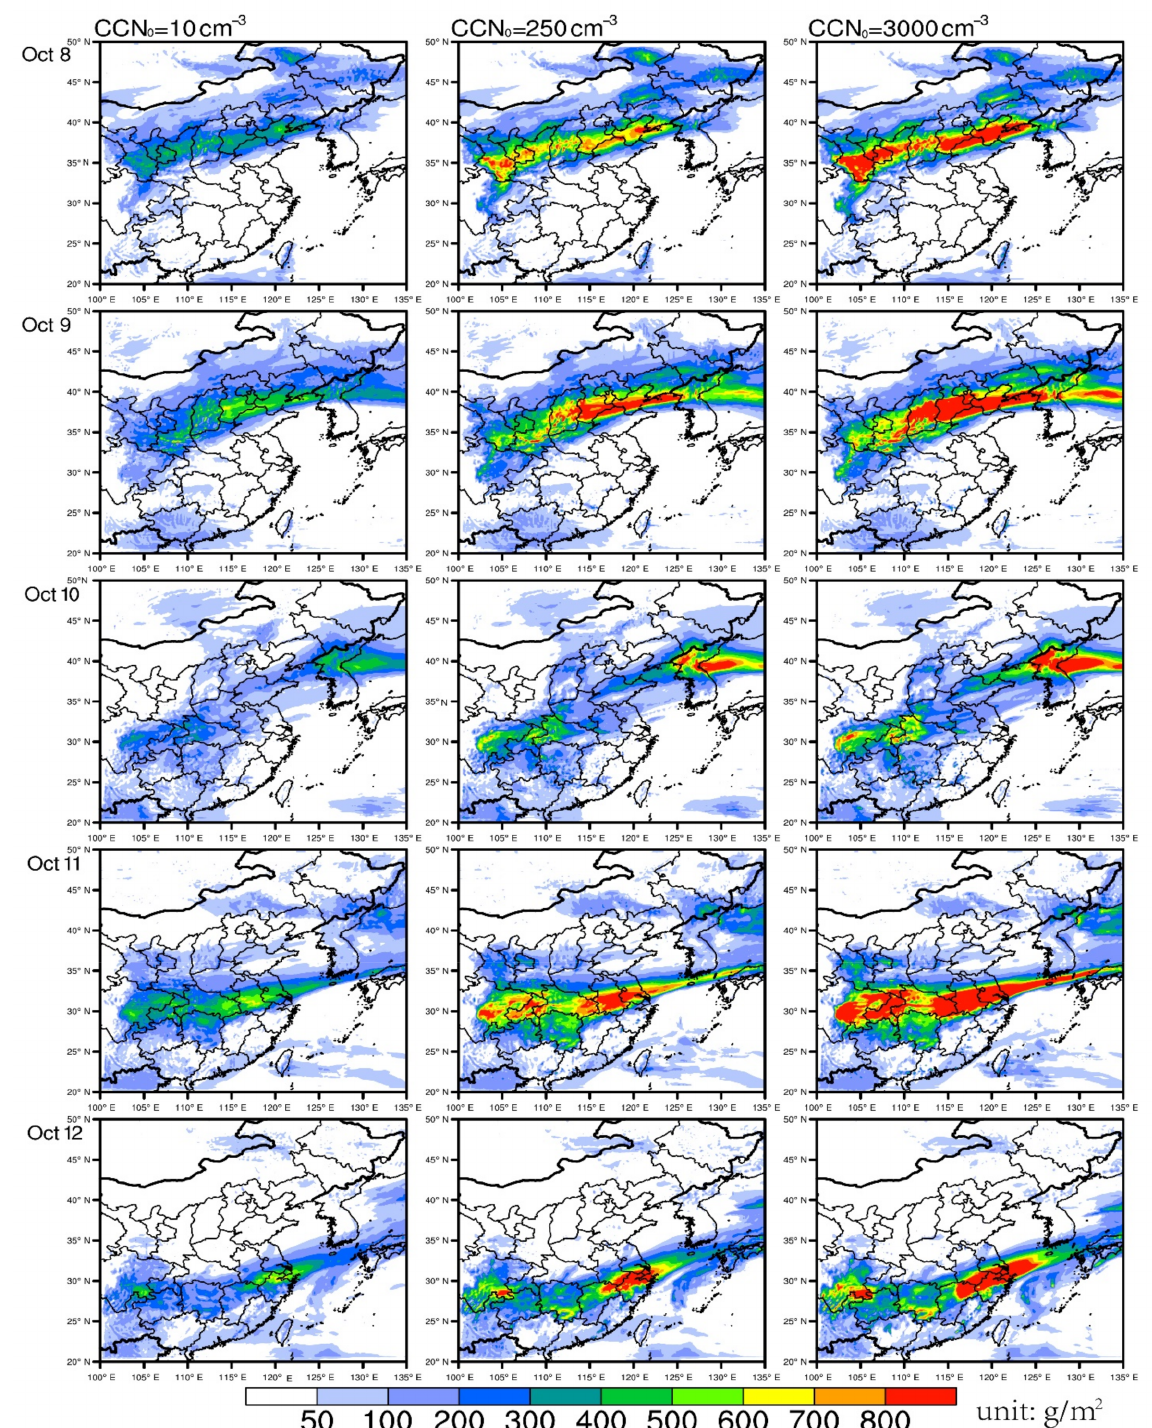
Figure 5. Daily averaged CLWP (g m − 2 ) by model from 8 to12 October ( left : CCN 0 = 10 cm − 3 ; mid : CCN 0 = 250 cm − 3 ; right : CCN 0 = 3000 cm − 3